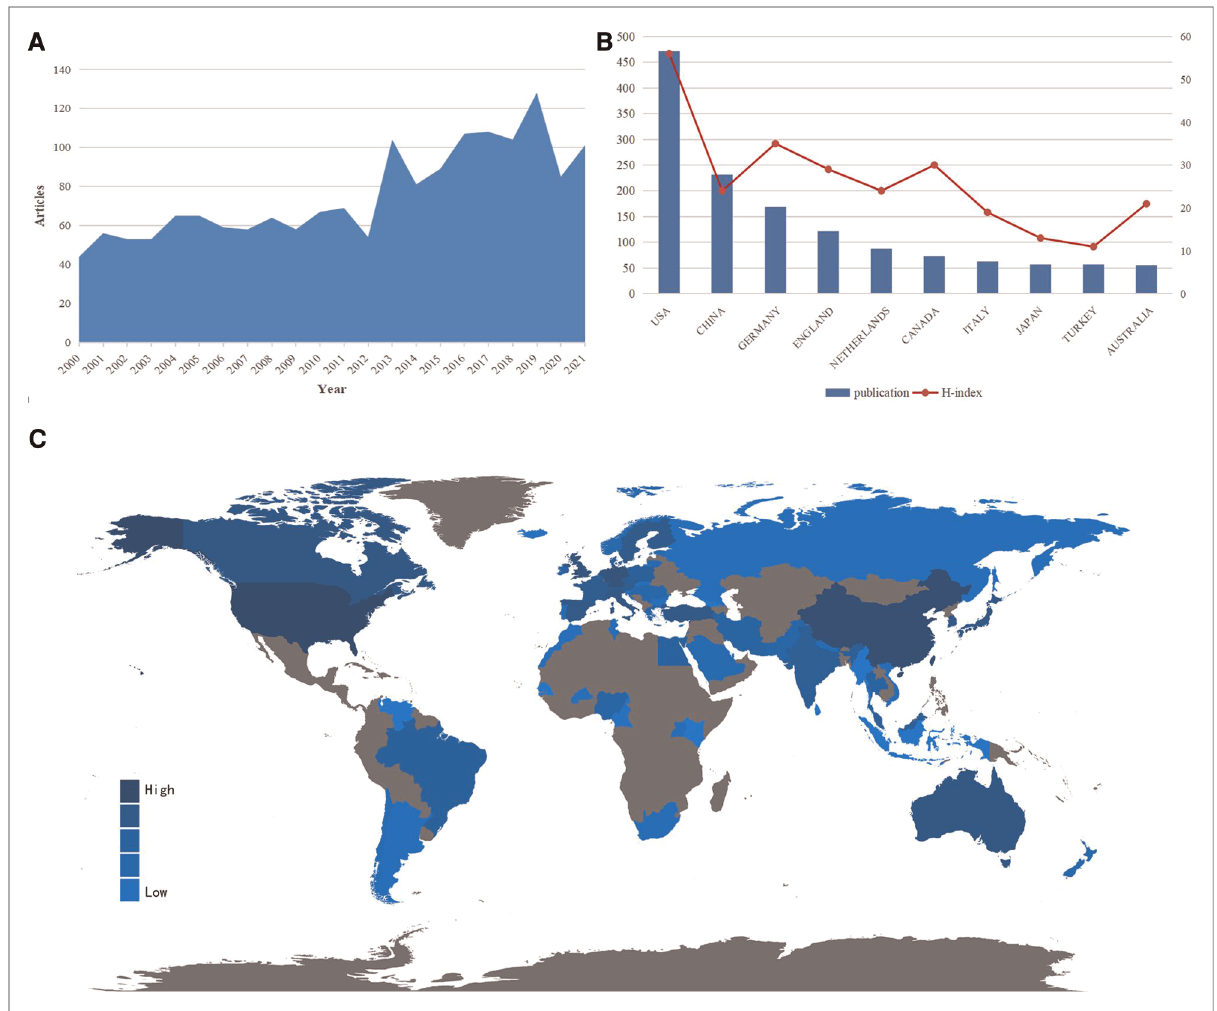
FIGURE 2 Overview of publications and trends in the fi eld of calcaneal fracture research. ( A ) The number of articles in the calcaneal fracture fi eld published every year between 2000 and 2021. ( B ) The top 10 countries and H-indexes in the fi eld of calcaneal fracture research. ( C ) World map showing the global distribution of calcaneal fracture research; the different colors represent different